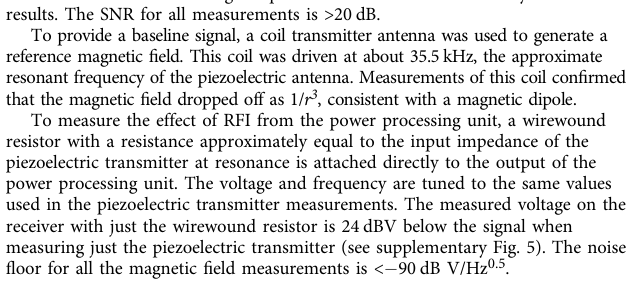
long solenoid. A grounded aluminum foil (cut at one point to ensure induced current is not shorted out) is placed around the coil to attenuate electric fi eld pickup. The two ends of the coil are differentially fed (with a common ground referenced to the receiver shield) to a Stanford Research Systems preampli fi er model SR650. The preampli fi er has a 115 dB/octive bandpass fi lter from 29kHz to 38kHz. The stop band attenuation is >80dB and the gain is set between 40 and 60dB. The signal is measured with a Tektronix TDS5054B oscilloscope with a sampling rate of 125kS s − 1 . This magnetic fi eld received is uncalibrated and is included as a relative measurement. For both the electric fi eld and magnetic fi eld data, the CW signals are measured for 4s total. At each range data point, four repetitions are measured. Each distance measurement was repeated twice. In addition, at each point the background was measured with the input signal turned off. Data is post processed by taking the DFT of each 4-s long interval. The magnitude of the signal at the frequency of